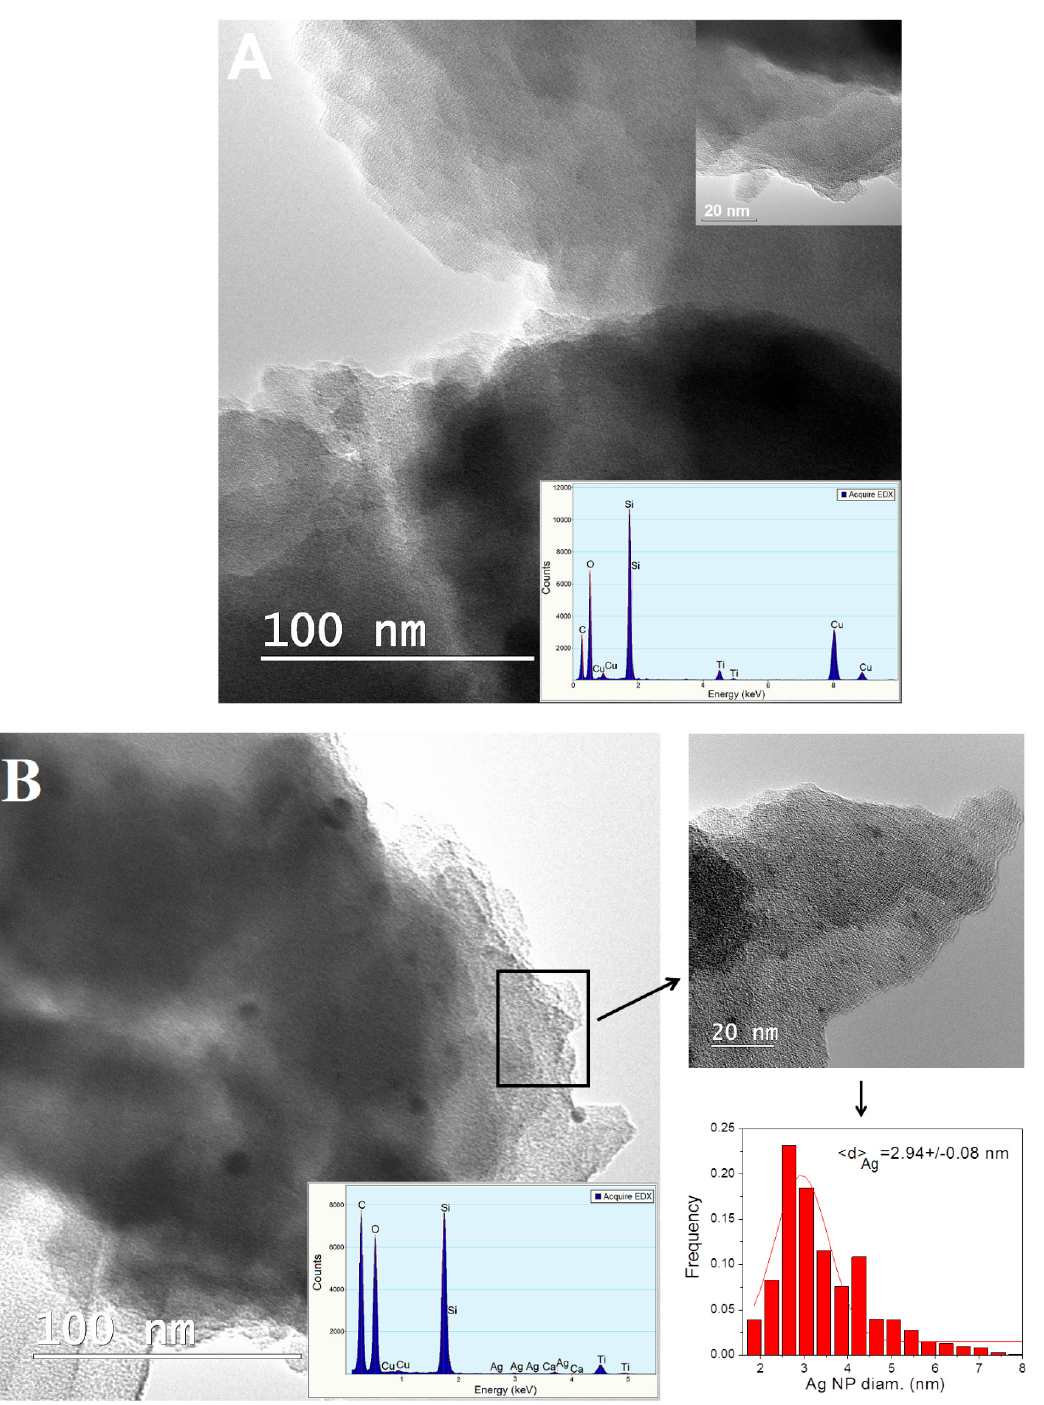
Figure 3. TEM images and EDX analysis of silica material (sample A) and of silver-based silica material (sample B), ob- tained as powders, and diameter histogram of the silver-based silica material (sample